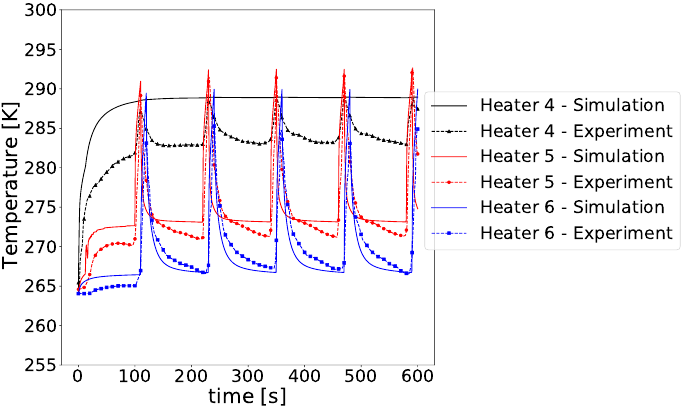
Figure 14. Comparison between experimental data and numerical results for the deicing Case. A qualitative description of the evolution of the liquid water films, the ice shape, and the temperature field in the ETIPS is shown in Figure 15 for t = 10, 99, 110 and 115 s. At t = 10 s, Figure 15 (top left) shows that the heating at the parting strip generates a runback liquid water film that freezes further downstream. This generates ice build-up, as shown in Figure 15 (top right) for t = 99 s. At t = 100 s, Heater 3 is activated. As this heater is located below the ice shape, its activation leads to the creation of a melted liquid layer. This is shown in Figure 15 (bottom left) (for t = 110 s). After t = 110 s, Heater 3 is deactivated. However, the ice bloc continues to melt due to thermal inertia. When a sufficient amount of the contact area between the ice and the airfoil has melted, the ice block is shed. This is shown in Figure 15 (bottom right).